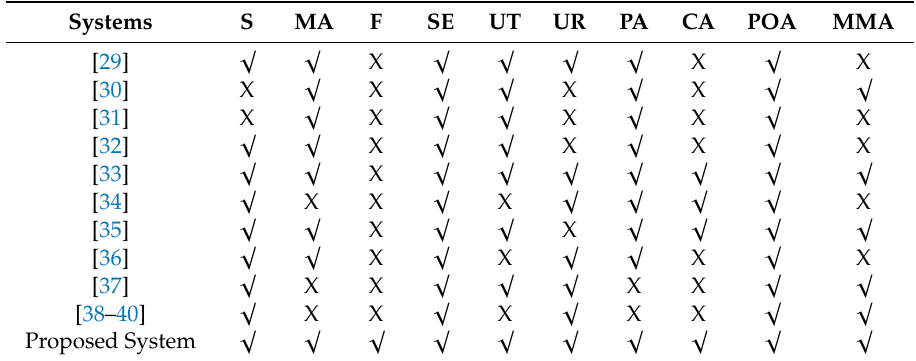
Table 1. Comparison of the Features of Presented System with Other Systems. S, simultaneously work; MA, determination of movement accuracy; F, giving feedback for movement correction; SE, skeleton extraction; UT, usability in training; UR, usability in rehabilitation; PA, being oriented towards physical ability; CA, being oriented towards cognitive ability; POA, to be able to make pose analysis; MMA, the ability to perform movement model